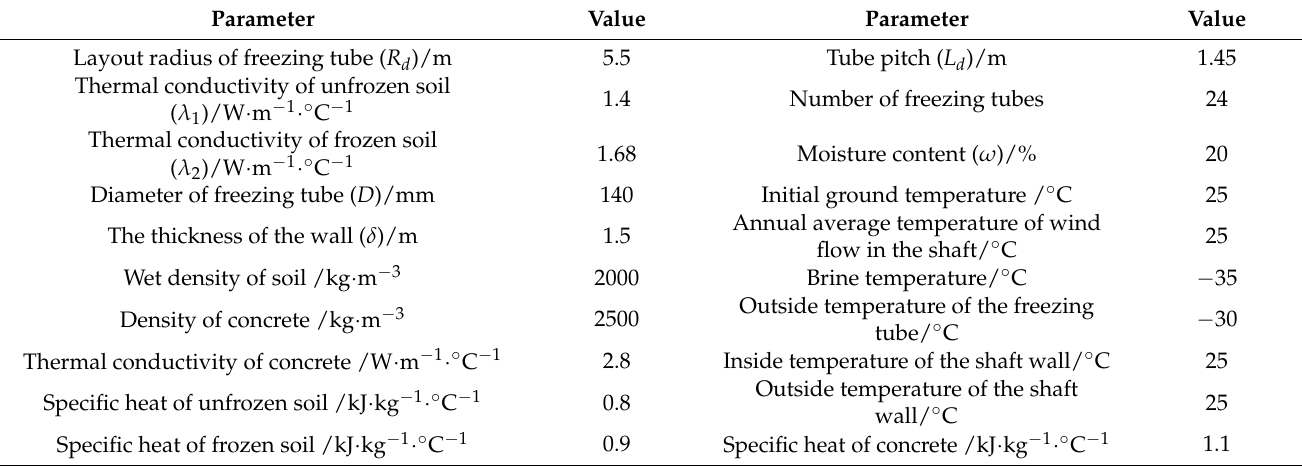
Table 3. Typical parameter values in the single-factor calculation.